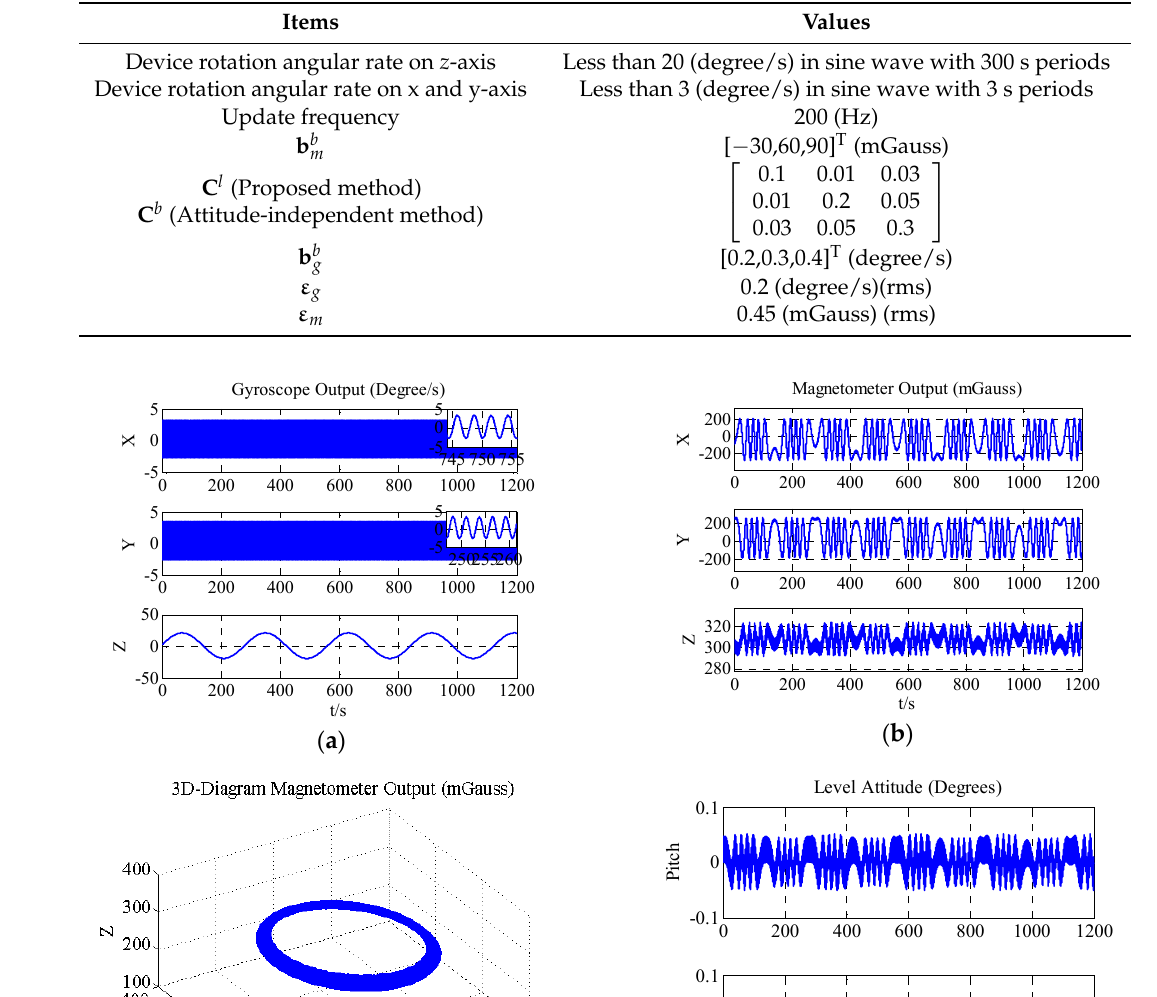
Table 2. Simulation setting.